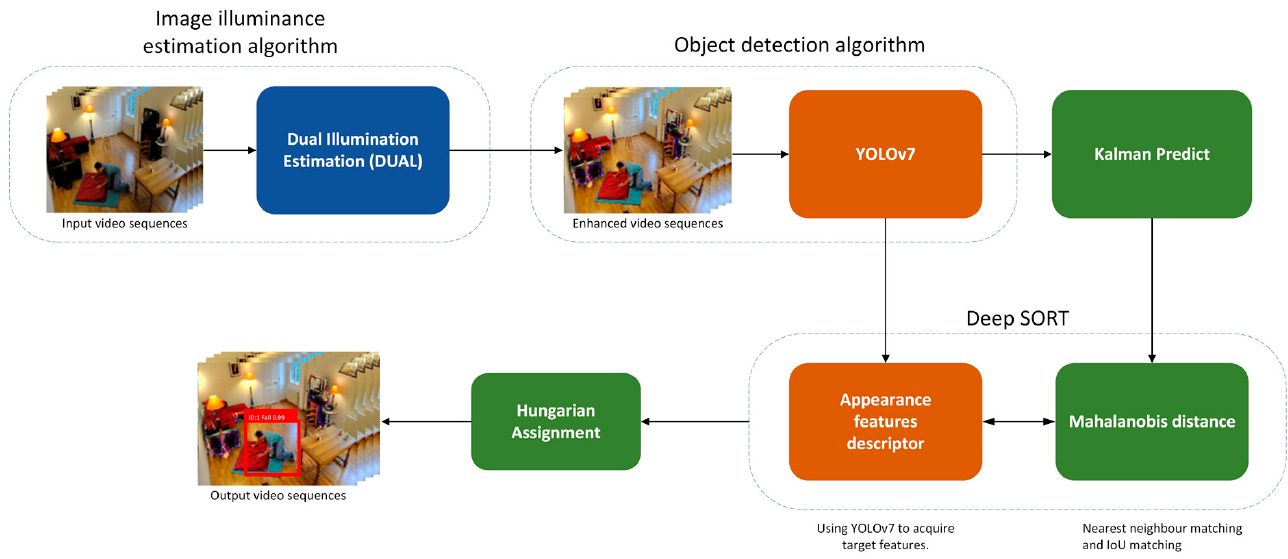
Figure 3. Schematic representation of the proposed framework.